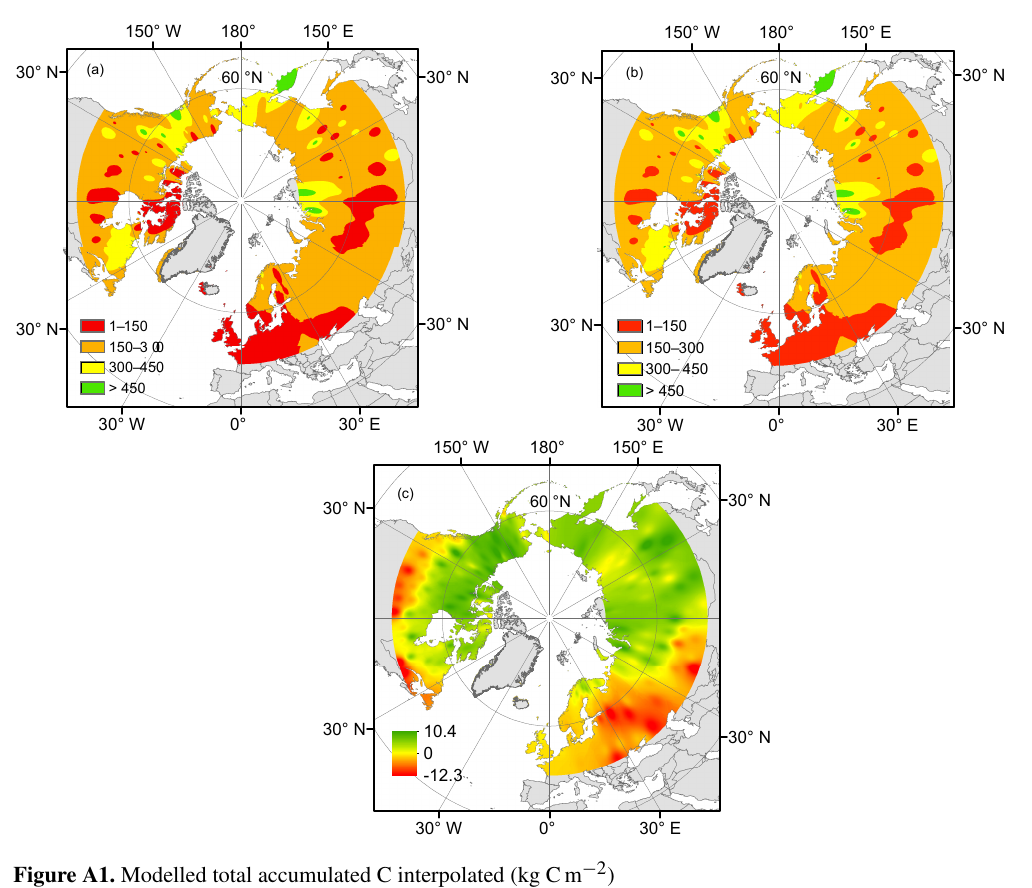
Figure A1. Modelled total accumulated C interpolated (kg Cm − 2 ) among simulation points for (a) 1990–2000 and (b) 2090–2100; (c) net change in total C accumulation (b–a)